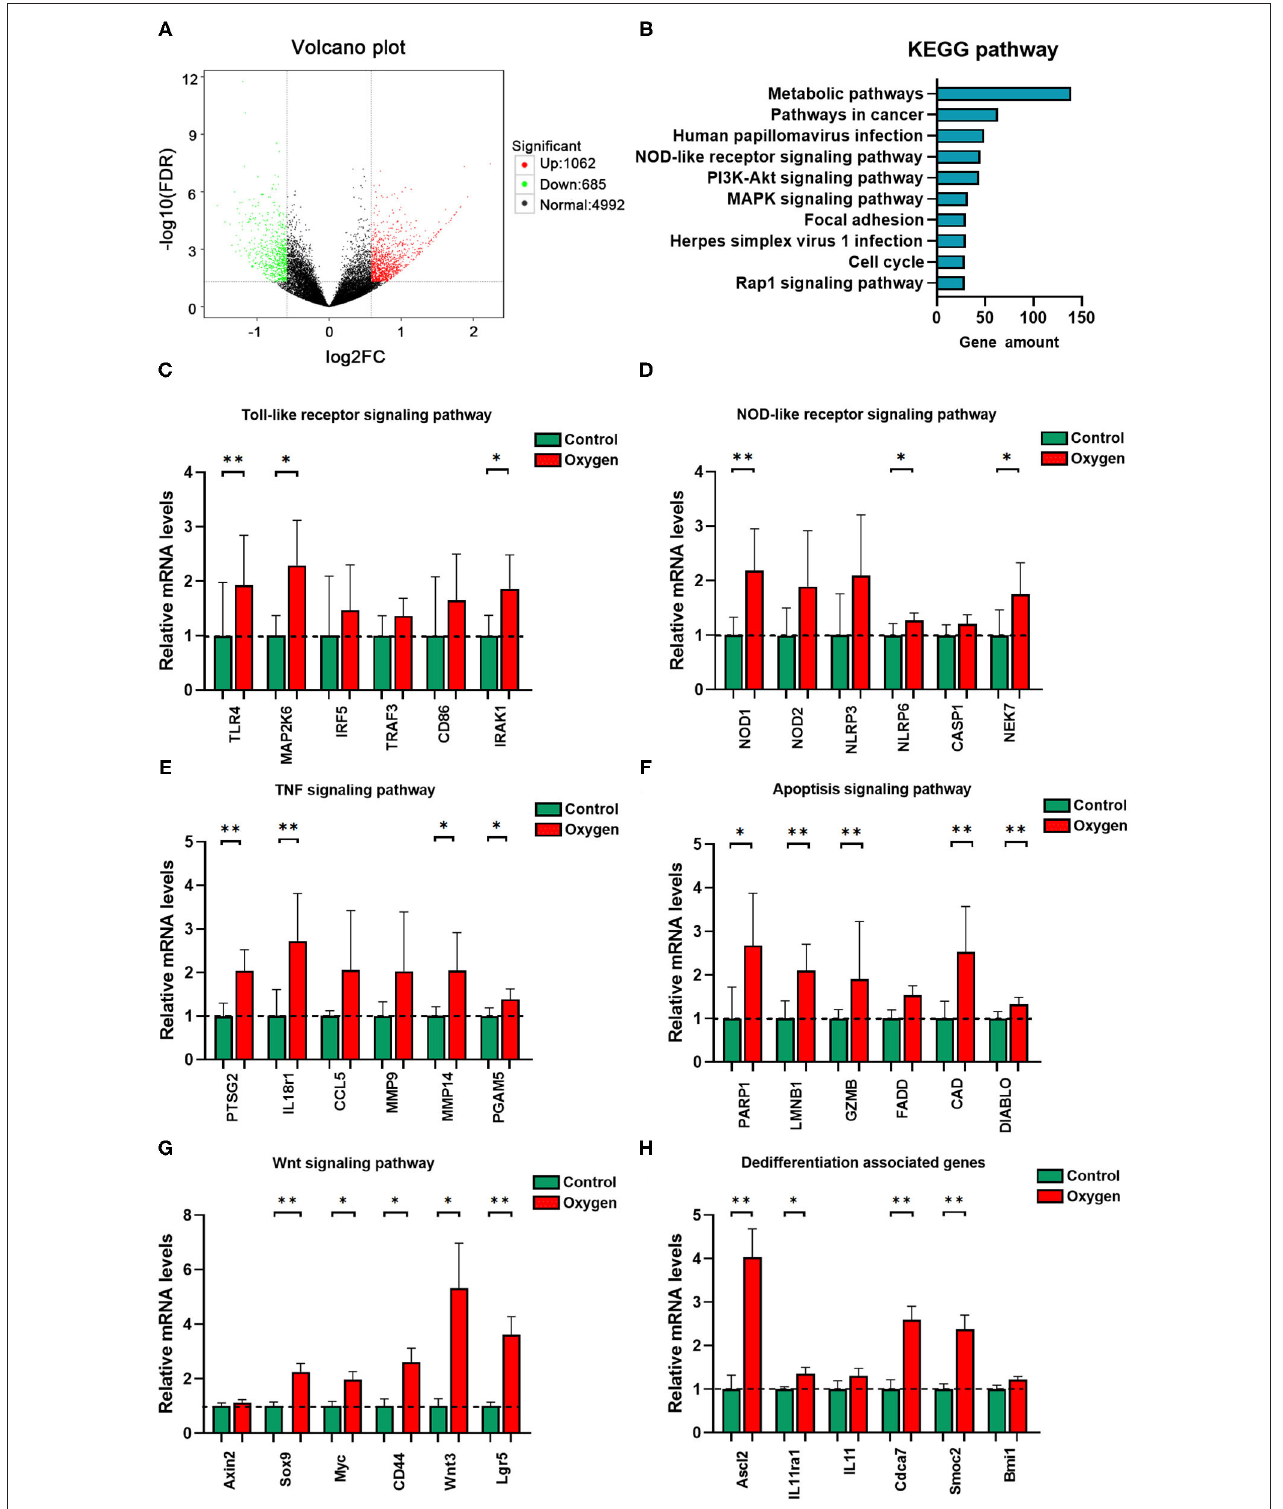
FIGURE 6 | Transcriptome analysis of oxygen-induced gut injury ( n = 6). (A) Volcano plot identifying DEGs between the oxygen and the control groups (Log 2 FC ≥ 1.5, FDR < 0.05). (B) KEGG pathway analysis shows the top 10 significant pathways ( P < 0.05) with the greatest amount of DEGs. (C) Relative mRNA levels of genes involved in the TLR signaling pathway. (D) Relative mRNA levels of genes involved in the NOD-like receptor signaling pathway. (E) Relative mRNA levels of genes